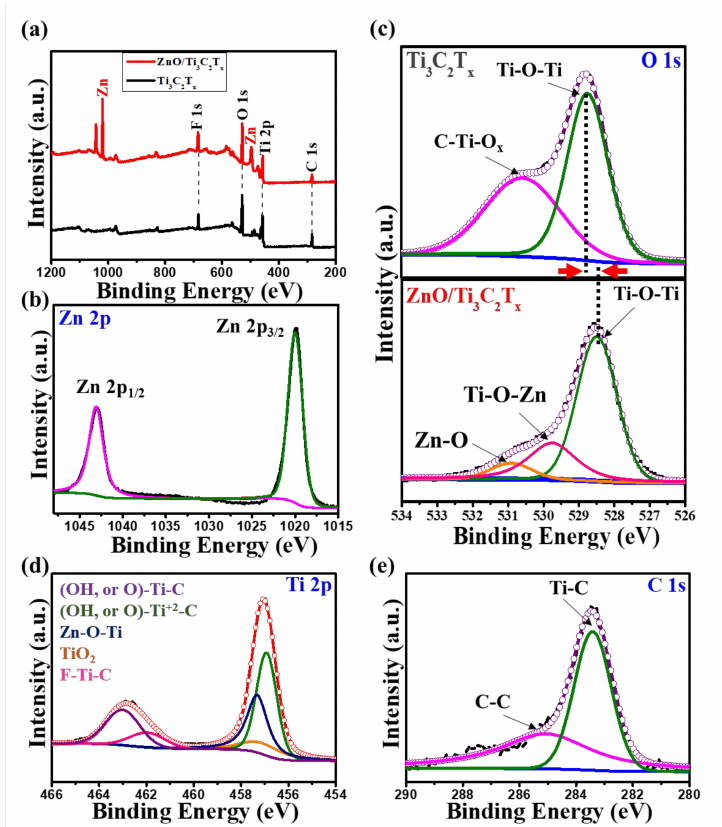
Figure 4. ( a ) Full XPS spectra of pure Ti 3 C 2 T x MXene and the ZnO / Ti 3 C 2 T x hybrid structure. Focused XPS spectra of ( b ) Zn 2p, ( c ) O 1s, ( d ) Ti 2p, and ( e ) C 1s for the hybrid structure are shown. O 1s spectrum for pure MXene is also displayed in ( c ) for